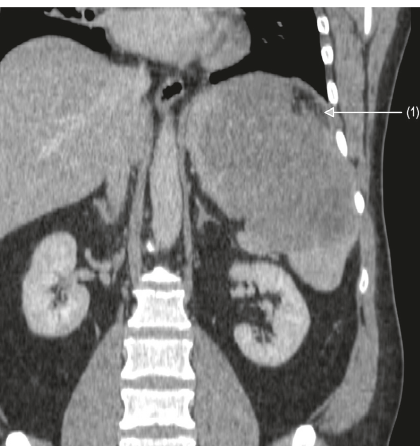
Figure 1: Abdominal CTscan showing an enlarged spleen with its visible rupture (1) and bleeding outside the capsule.